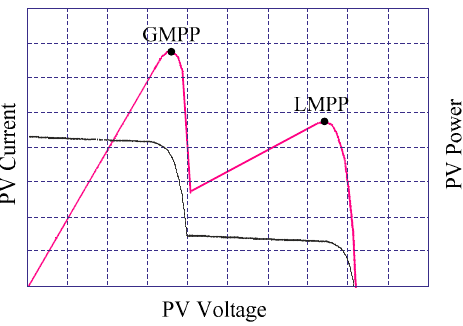
Figure 10. PV V-I and V-P characteristics under partial shading.